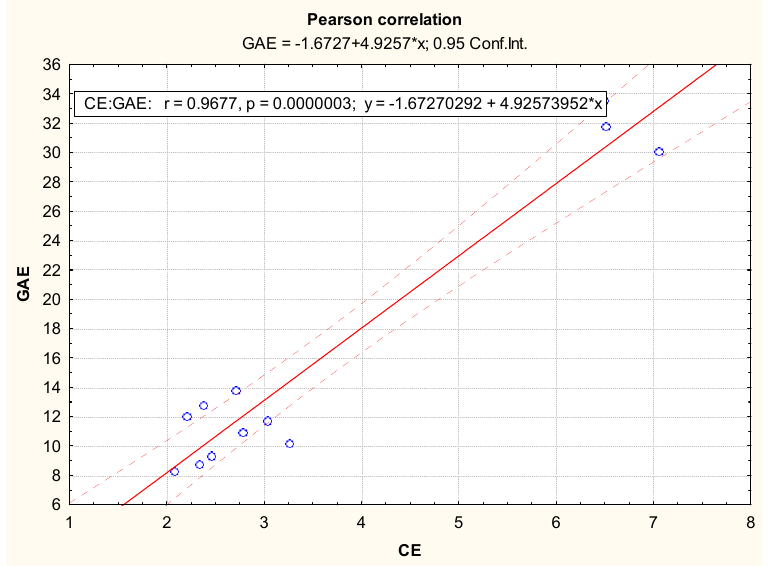
Figure 3. The Pearson correlation between total phenolic content (expressed as GAE) and total flavonoid content (expressed as CE).